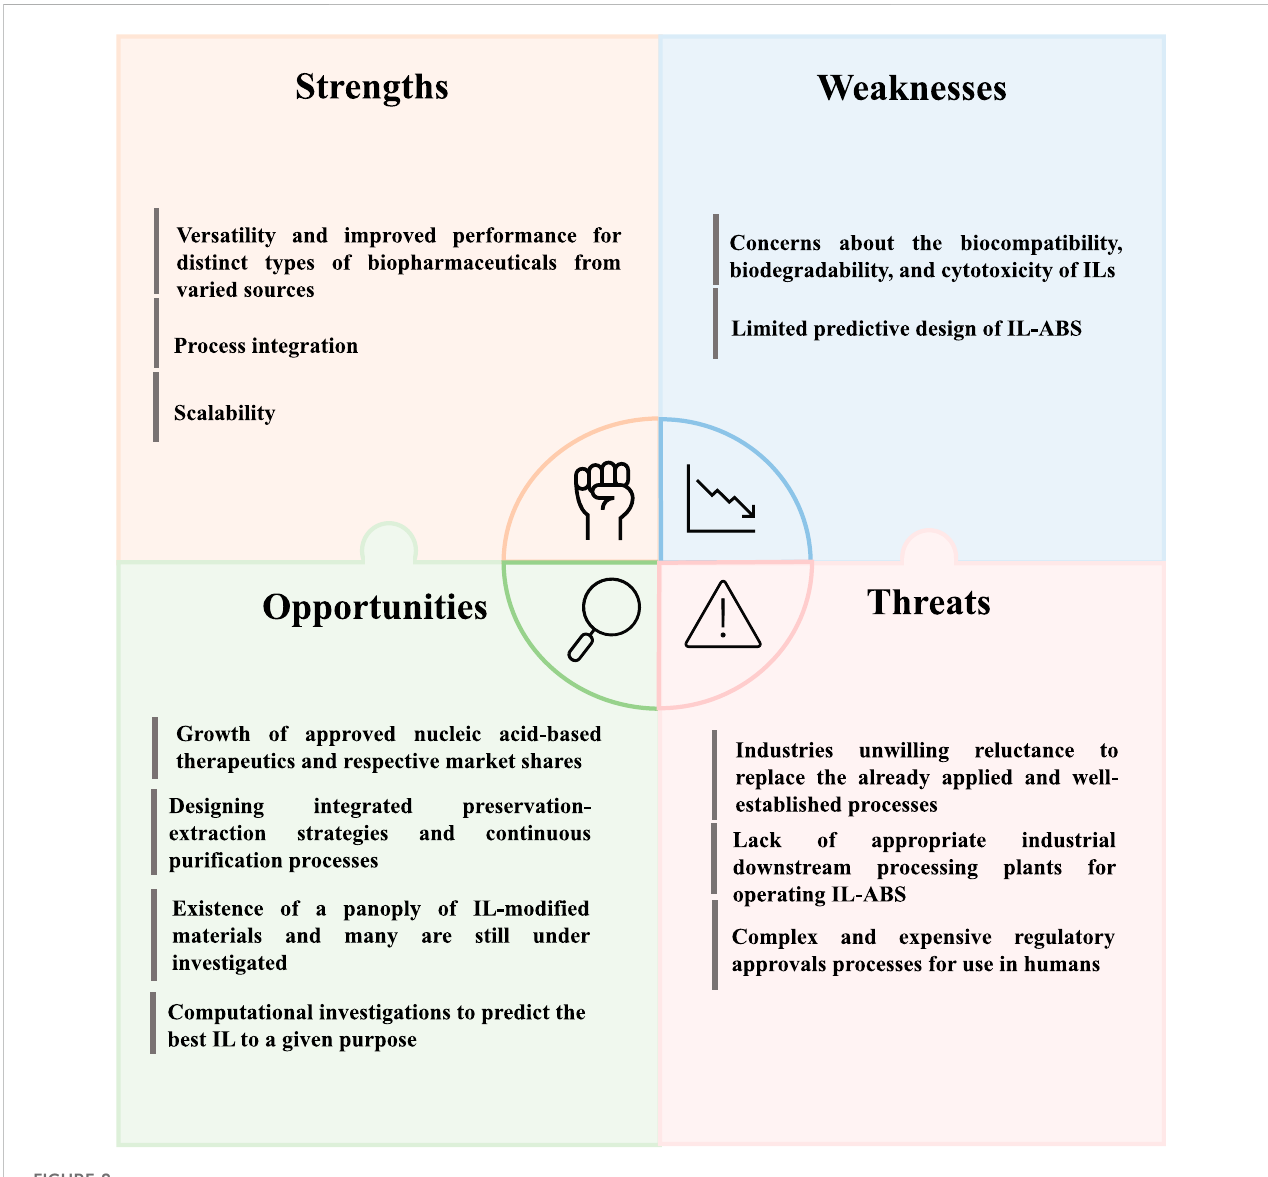
FIGURE 8 SWOT analysis emphasizing the major strengths, weaknesses, opportunities, and threats of the application of IL-based approaches for the downstream processing and formulation of biopharmaceuticals.